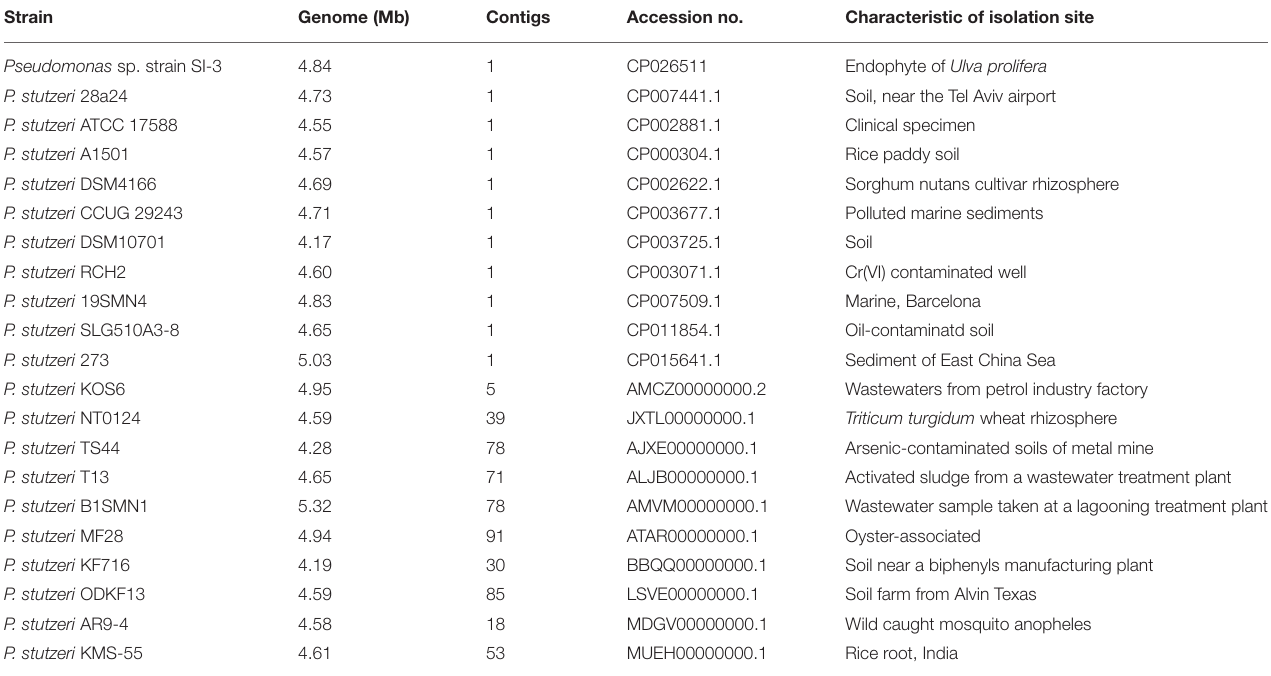
TABLE 1 | General information of Pseudomonas sp. strain SI-3 and 20 P. stutzeri strains. Strain Genome (Mb) Contigs Accession no. Characteristic of isolation site Pseudomonas sp. strain